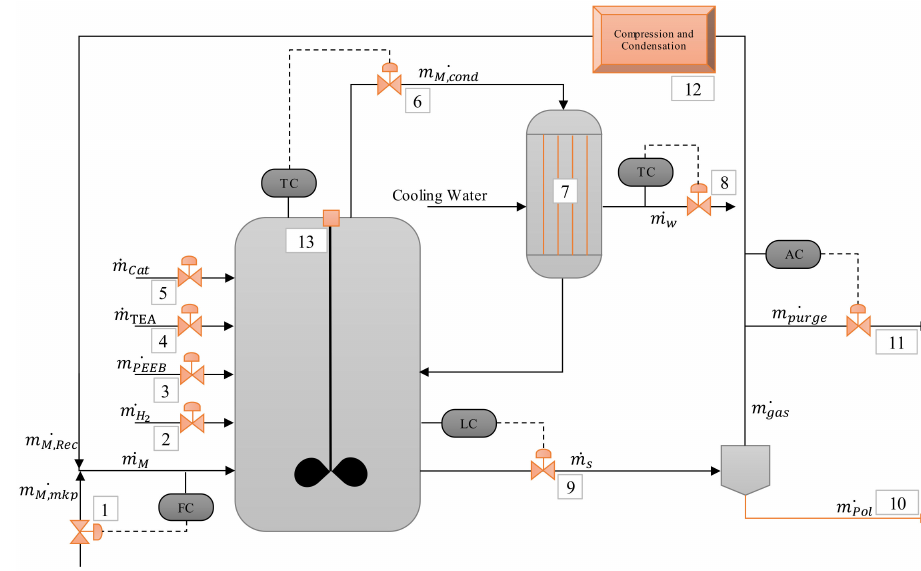
Figure 12. Equipment considered for process malfunctions highlighted in orange. Table 4. Possible failure